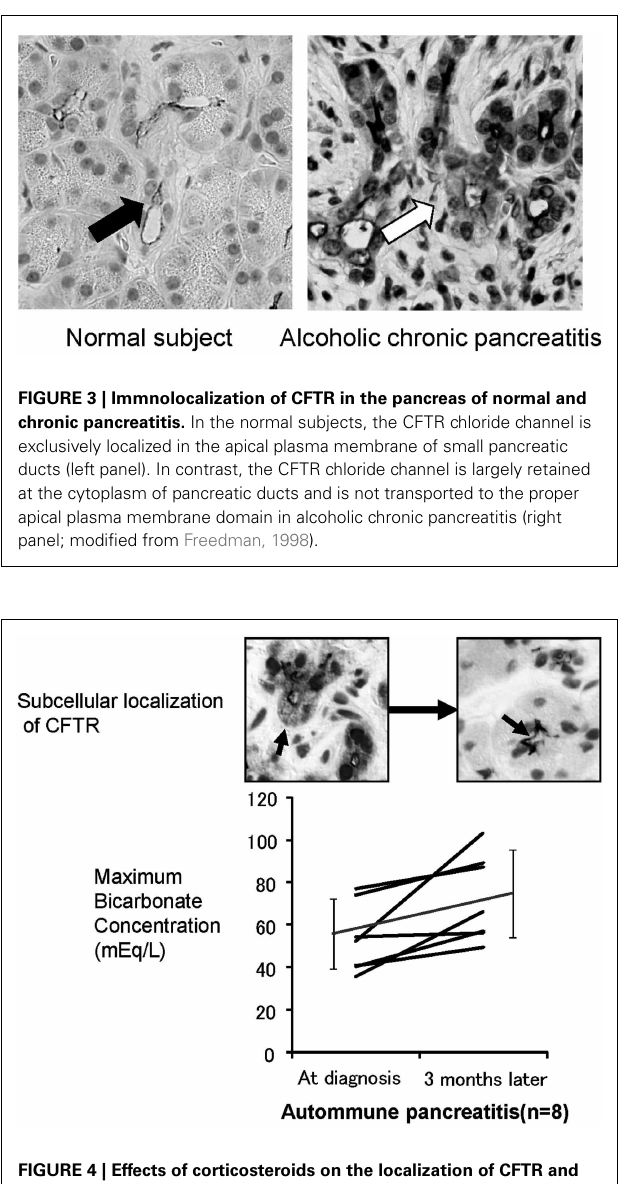
concentration in pancreatic juice ( Figure 4 ). These data